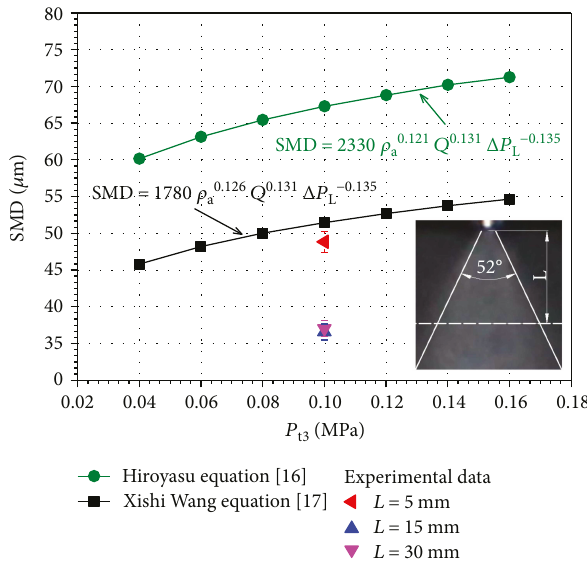
Figure 9: Variation in SDM with inlet